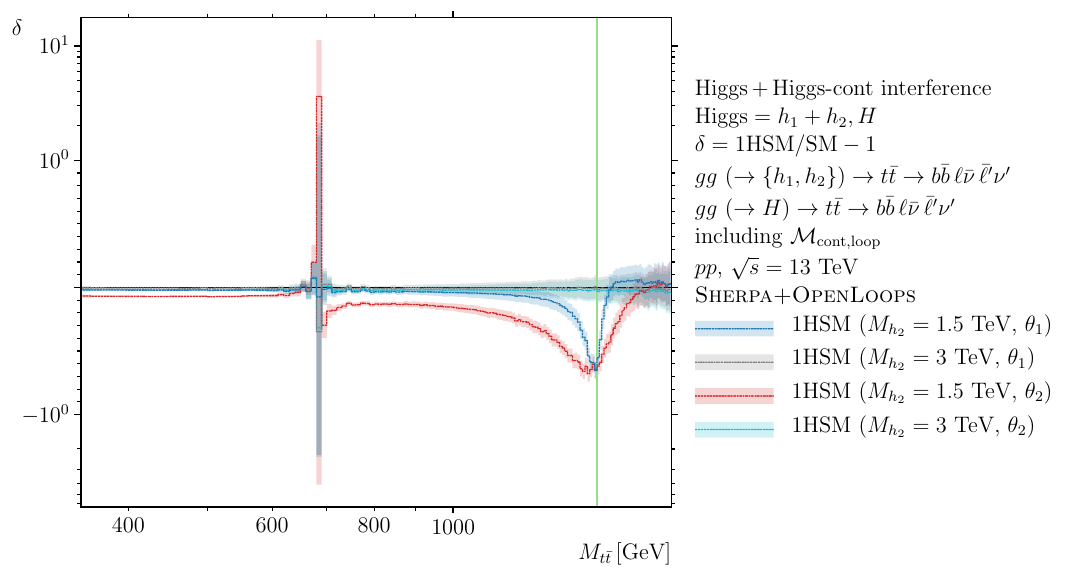
Figure 21 . M distributions of the relative deviation δ = R t ¯ t its interference with the background in the 1HSM ( M h ) t ¯ t b ¯ b (cid:20) ¯ ν ¯ (cid:20) (cid:31) ν (cid:31) in pp collisions at √ s = 13 TeV. R is the ratio of SM for gg ( h 1 , h 2 , H } → → → { σ ( h 1+2 +I(C + (cid:31) )) to σ ( H +I(C + (cid:31) )). Other details as in figure